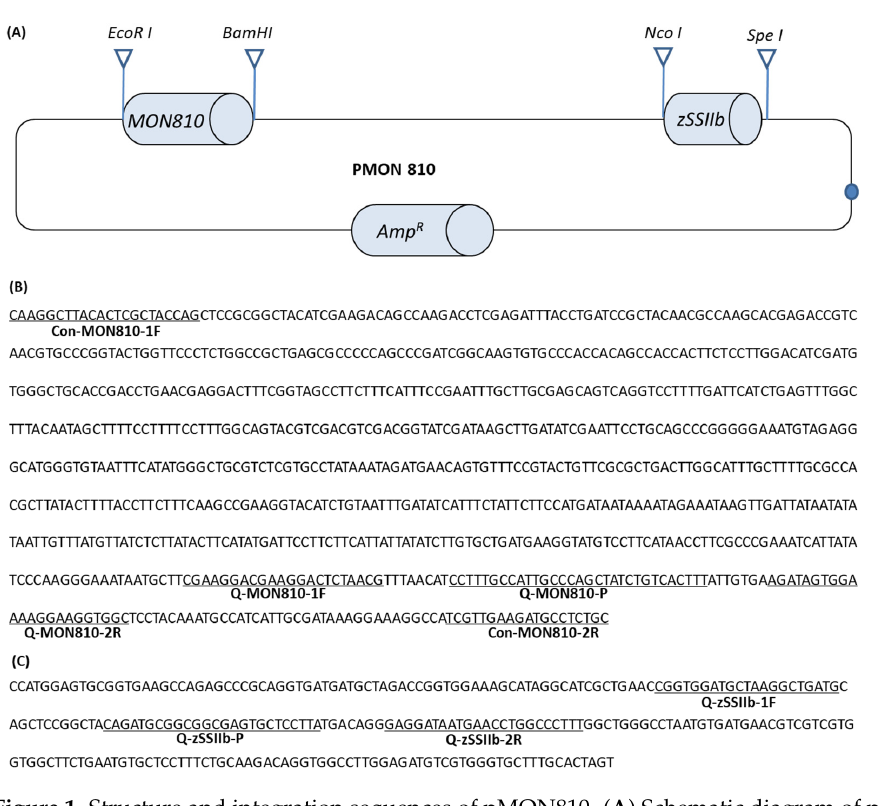
Figure 1. Structure and integration sequences of pMON810. ( A ) Schematic diagram of pMON810. Amp R , ampicillin-resistant gene; MON810 , 5 ′ event-specific sequence of GM maize 810; zSSIIb , a specific fragment of maize endogenous reference gene zSSIIb ; EcoRI , Pst I , BamHI , NcoI and SpeI indicate the corresponding restriction endonuclease sites. ( B ) Nucleotide sequences of the 5 (cid:48) flanking sequence of GM maize MON810. ( C ) Partial nucleotide sequence of maize endogenous reference gene zSSIIb . The underlined and labeled sequences are the primer pairs and TaqMan probes used in this